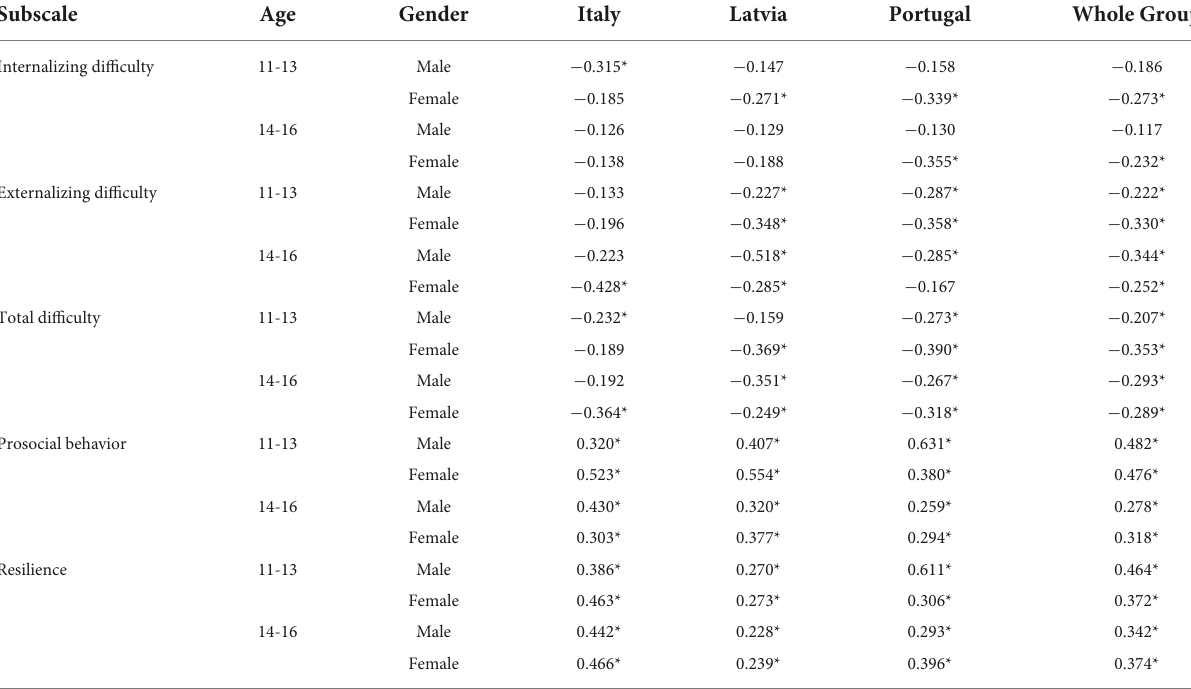
TABLE 11 Correlation between changes from T1 to T2 in SSIS-SEL and changes in SDQ and CD-RISC-10. Subscale Age